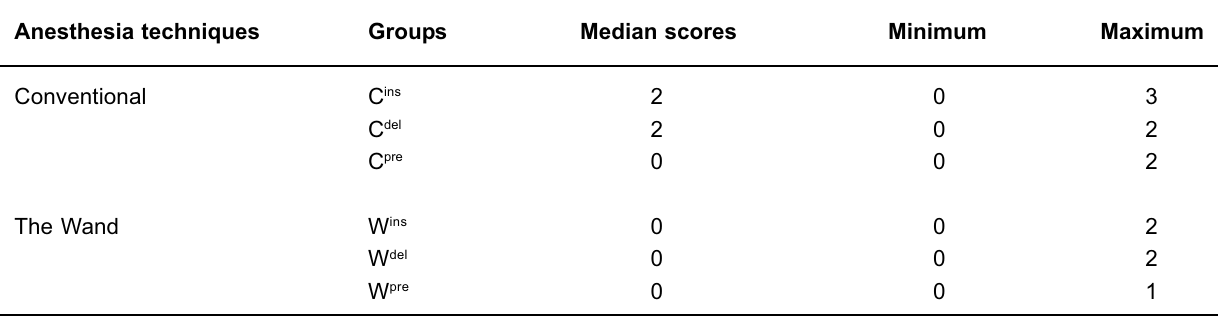
TABLE 3- Descriptive statistics for the two anesthesia techniques during 3 phases